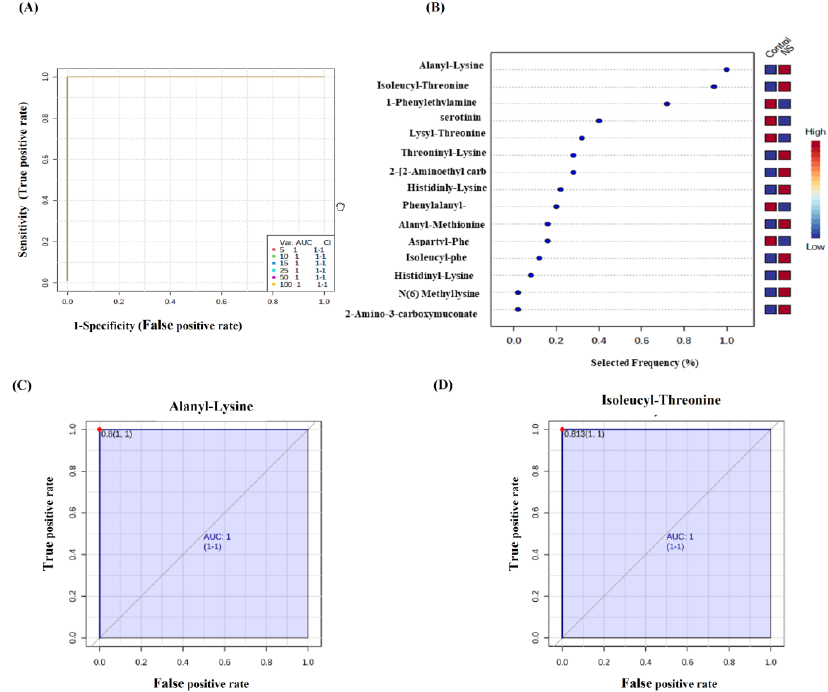
Figure 4. Receiver operating characteristics (ROC) curve and loading Plots for significant metabolites in serum of patients with NS. ( A ) ROC was generated using the PLS-DA model showing area under the curve (AUC) for the top five variants = 1. ( B ) Frequency percentage plot of the altered metabolites in NS patients when compared with controls. ( C ) Alanyl-Lysine (AUC = 1) and ( D ) Iso- leucyl-Threonine (AUC = 1) were up-regulated in NS patients when compared with control. Data were normalized, transformed, and scaled by median log and Pareto scaling to make sure all the data were under Gaussian distribution. 3. Discussion NS has emerged as one of the most prevalent primary kidney disorders, and its pro- gressive forms are associated with an increased risk of developing chronic renal disease (CKD) [23]. Additionally, NS is a diverse condition that may have a variety of underlying causes; making a definitive diagnosis is often inaccurate, particularly in primary care set- tings [8,24]. Therefore, it is necessary to identify novel biomarkers to aid in early diagnosis and facilitate treatment and disease follow-up. Despite the growing field of metabolomics as a promising technique to study disease for diagnostic and therapeutic purposes by measuring the overall expression of small mol- ecules (< 1500 Da) [25], few studies have focused on NS in humans [1,9]. We collected random samples, although there could be a very marginal effect of fasting on the metab- olomics profile, this effect is not major and was normalized with the fold change filter [26]. Therefore, CIL LC – MS robust method for metabolomics biomarker discovery was ap- plied, to identify the predictive biomarkers for NS based on the serum metabolite changes allowing the detection of very low abundant (pmol to fmol) metabolites and 13 C-labeled pool served as an internal standard and compensated for the fluctuations in MS response. 3C-labeled metabolite and its corresponding 12C-labeled metabolite in a 12C-/13C- mixture were detected as peak pairs and their concentration was found based on the peak area ratio and these values were used to quantify the individual metabolite in the samples.